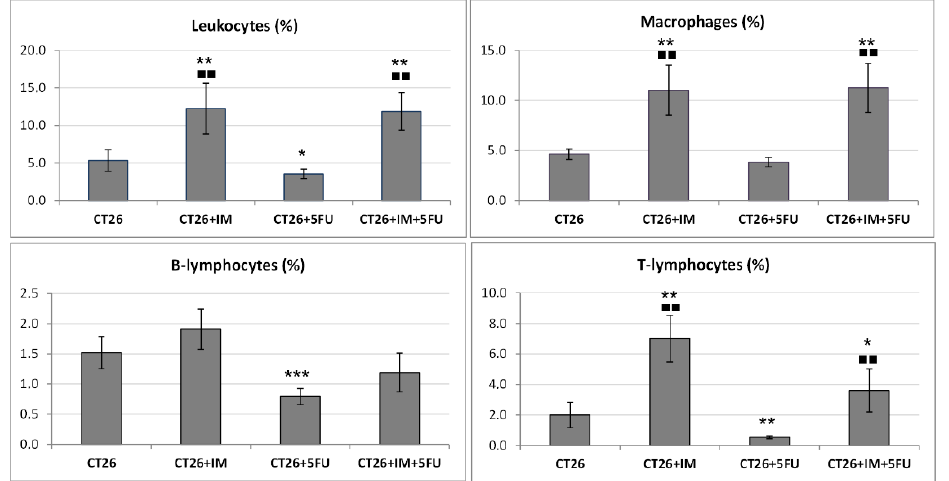
Figure 3. Immune cell proportions (%) in the tumour microenvironment. Data are expressed